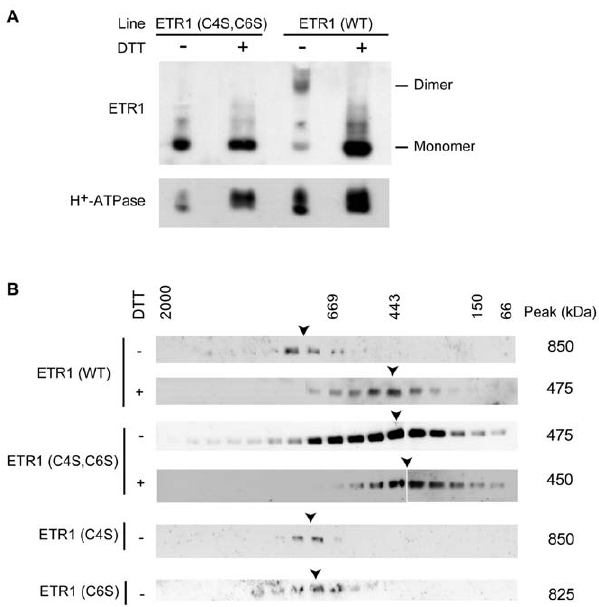
Figure 3. Effect of reduction and cysteine mutations on the size of the ETR1 protein complex. (A) Mutation of Cys4 and Cys6 of ETR1 prevents formation of the disulfide-linked dimer. LPC-solubilized microsomes from plants expressing ETR(wt) or ETR1(C4S,C6S) were incubated in SDS-PAGE loading buffer in the presence or absence of 300 mM DTT, then separated by SDS-PAGE and analyzed by immuno- blot. (B) Gel-filtration analysis of wild-type (wt) and cysteine mutants of ETR1. LPC-solubilized microsomes from the indicated plant lines were fractionated on Superose 6HR and the elution profile for ETR1 determined by immunoblot analysis. 5 mM DTT was included in the solubilization and FPLC buffers as indicated.